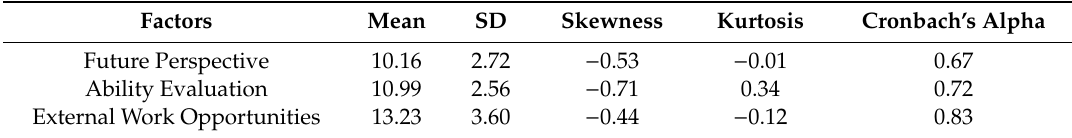
Table 3. Factors’ descriptive statistics.